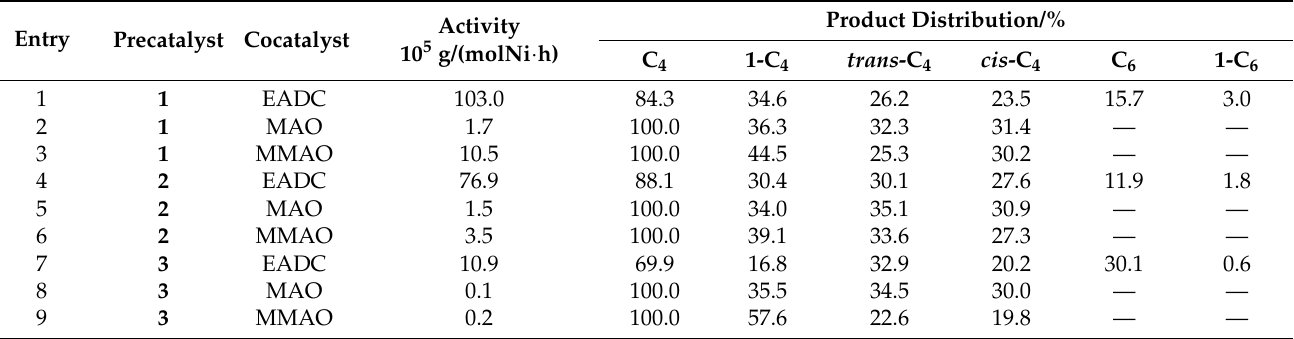
Table 2. Effects of the cocatalyst on precatalysts 1–3 on ethylene oligomerization a .